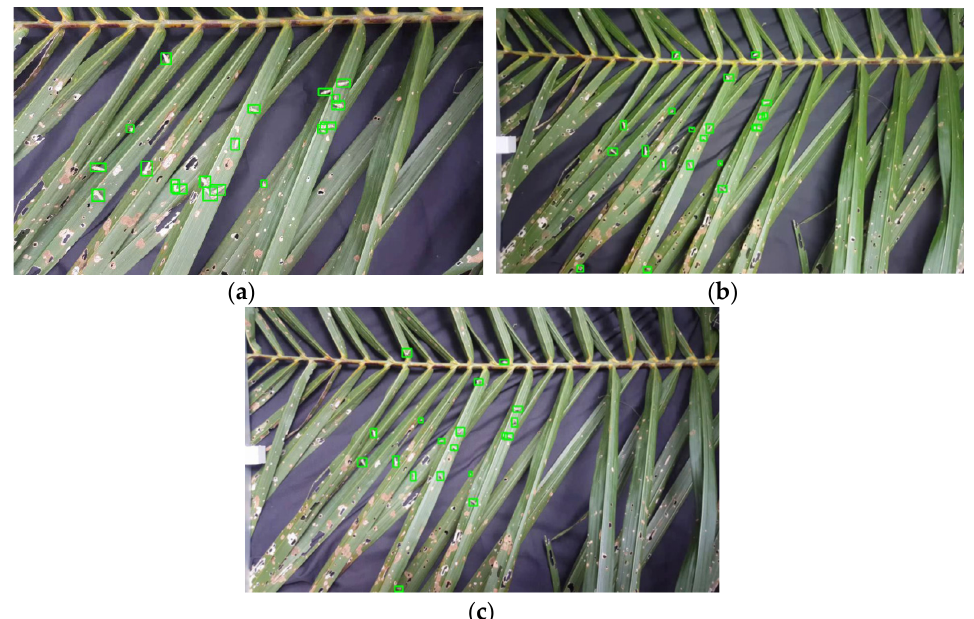
Figure 13. Detection based on 50 cm camera distance through DL with: ( a ) open, ( b ) closed and ( c ) half-open areas.